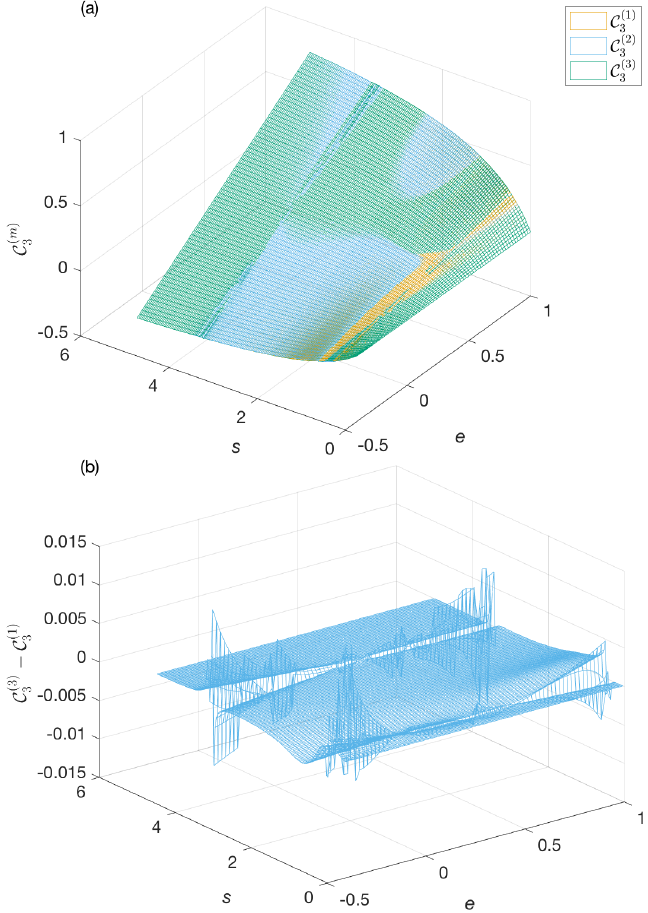
Figure 4. ( a ) Approximate inertial manifolds for the three-variable model obtained at the same level of iteration ( k = 3) for different orders of expansion of the delayed term. Parameters: ε 1 = β = α = 0.1, γ = 1.5, κ = 0.2, n = 4 and δ = 0.4. On the scale of this figure, regardless of how we rotate the graph, the three surfaces appear very similar to the eye. ( b ) Difference between C